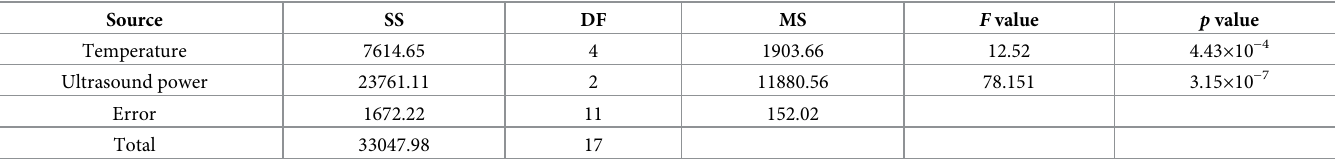
Table 2. Analysis of variance for drying